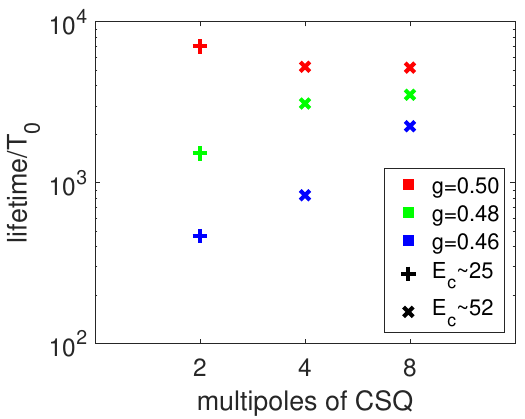
Figure 27. Lifetimes of CSQs for different couplings ( g ) and multipoles. Lifetimes are shown in units of T = 2 π/m . 0